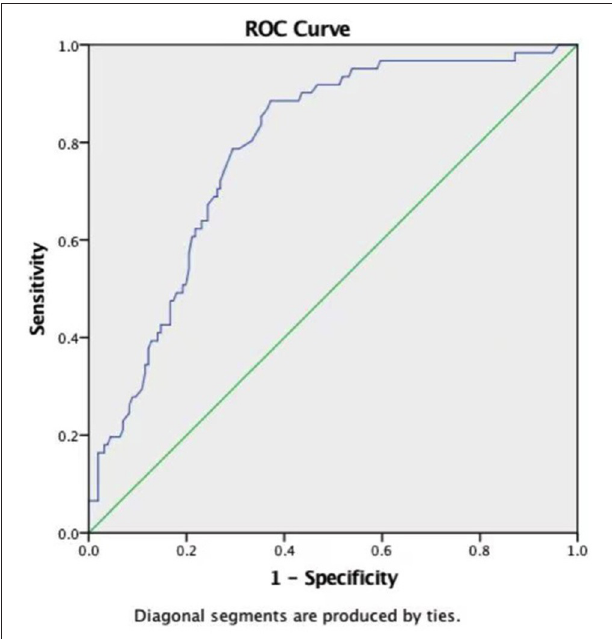
FIGURE 1 | Receiver operating characteristic curves of aortic cross-clamping (ACC time).